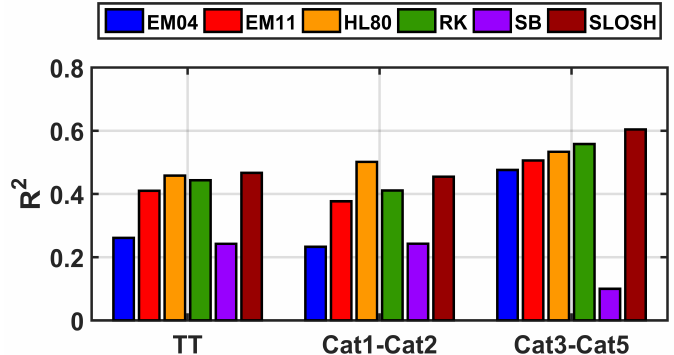
Figure 4. Radial wind profiles mean r 2 for tropical storm (TT), categories 1 and 2, and categories 3–5 for all